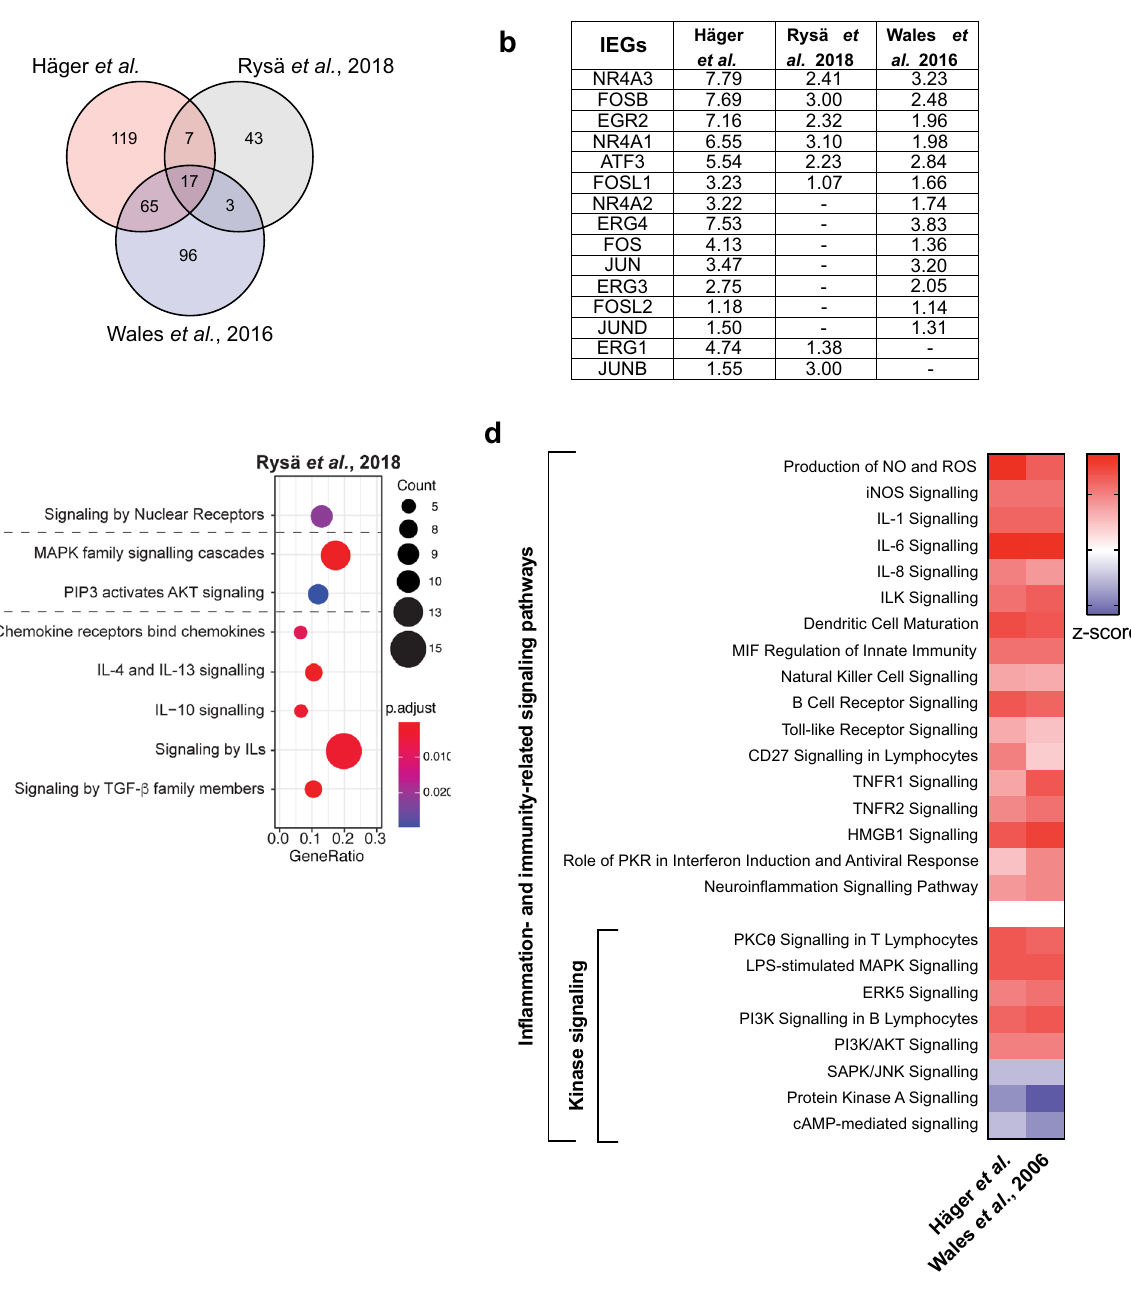
Figure 3. Meta-analysis of the injury-induced transcriptional response (at 1 h post-injury) shows that the transcriptional response is conserved. ( a ) Overlap of significantly upregulated genes (> twofold, P < 0.05) between our RNA-seq dataset derived from digitonin-injured MCF-7 breast cancer cells and two others from ionomycin-treated MCF7 breast cancer cells (Wales et al ., 2016 1 ) and mechanically stretched cardiomyoctes (Rysä et al . , 2018 4 ). ( b ) log 2 fold changes of immediate-early response genes (IEGs) (with P < 0.05) across all datasets included in the meta-analysis. ( c ) Dot-plot showing the predicted enriched pathways from the transcriptomic dataset by Rysä et al . 4 as a function of Gene Ratio (i.e. percentage of total differentially expressed genes in the given GO term), Count (i.e. number of input genes associated to a specific pathway) and P -adjusted values. The enriched pathways were grouped into the three parts of the transcriptomic response ( Part 1 : induction of immediate-early response genes; Part 2: activation of specific kinase-dependent pathways; Part 3: activation of inflammatory and immune responses). Pathway enrichment analysis was conducted by the ReactomePA. ( d ) Heatmap showing the signalling cascades predicted by the Ingenuity Pathway Analysis to be the most significantly changed in our RNA-seq data and the transcriptomic data reported by Wales et al ., 2016 1 . These pathways are significantly associated to the dataset (-log( P -value) > 1.3) and have a z-score that reflects their predicted activation state (a positive/negative z-score indicates